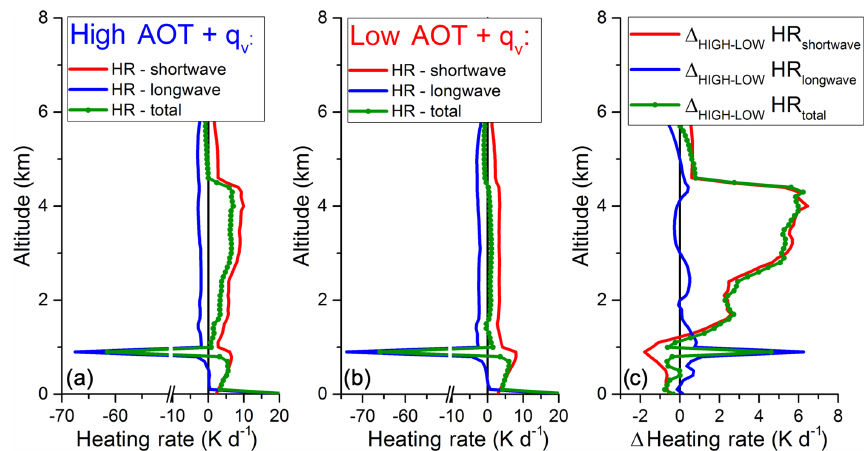
Figure 13. Calculated heating rate profiles (Kd − 1 ) in shortwave (red line), longwave (blue line) and total budget (green dot line) at 12h, for (a) average high cases (AOT 865nm = 0 . 26 and water vapour typical for high situations), (b) average low cases (AOT 865nm = 0 . 06 and water vapour typical for low situations) and (c) the difference between the high- and low-heating-rate profiles.